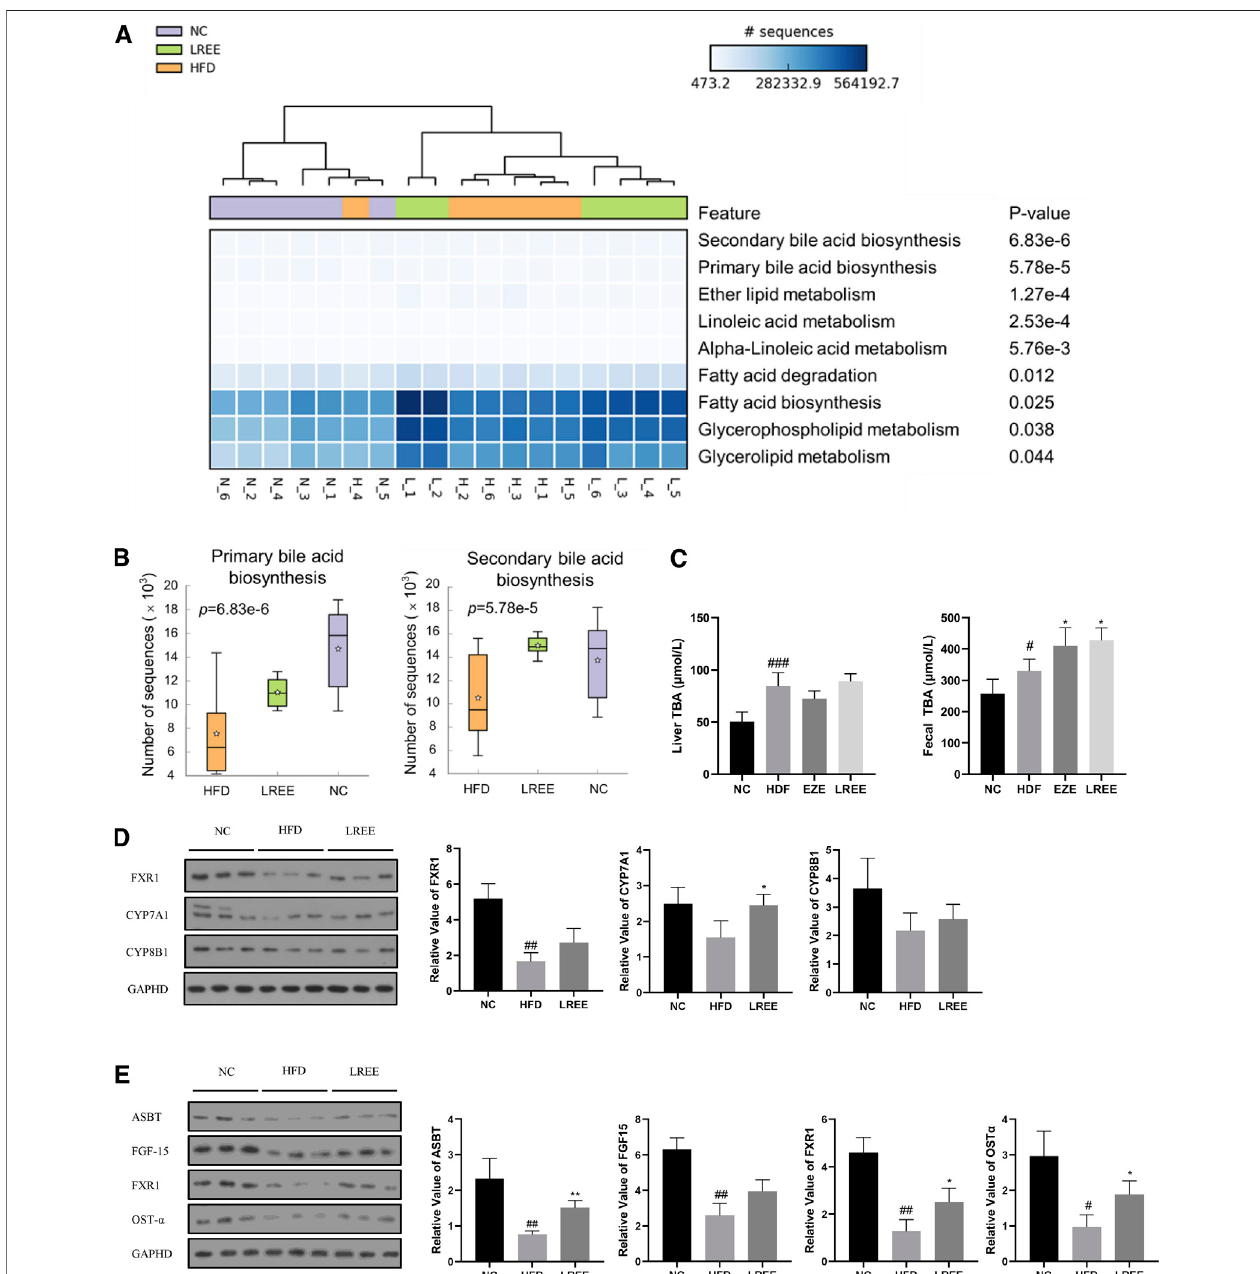
FIGURE 5 | (A) Enrichment analysis of the metabolic function of intestinal fl ora in three groups. The darker colors in the cells suggest that more microbiota was involved. The top ranking on the right indicates a more signi fi cant difference between the groups. (B) The abundance of bacterial fl ora involved in bile acid synthesis between different groups. (C) Levels of total bile acids in liver and feces. (D) Expression of the major proteins involved in primary bile acid synthesis in the liver. (E) Expression of major proteins involved in bile acid reabsorption in the ileum. # p < 0.01, ## p < 0.01, ### p < 0.001 via the NC group; * p < 0.05, ** p < 0.01 via HFD